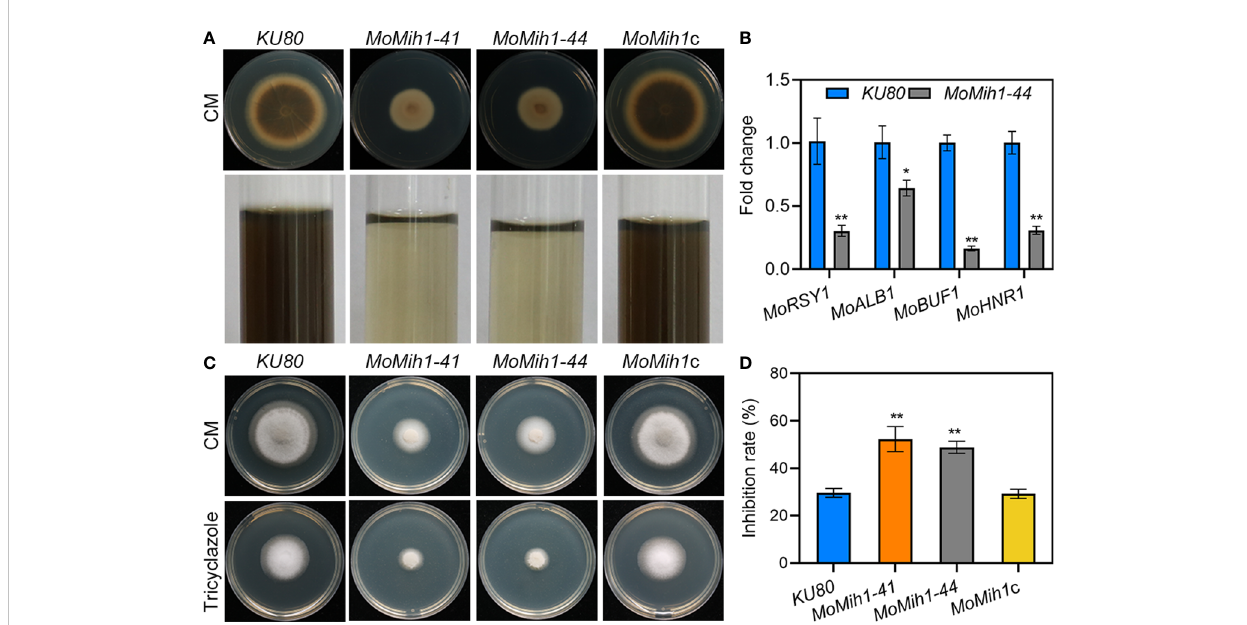
FIGURE 7 MoMih1 is required for melanin pigmentation of M. oryzae . (A) Colony pigmentation of the MoMih1 mutant. All the strains were inoculated on CM and cultured at 28°C for 5 days. Reduced melanin pigmentation was observed on both CM agar and liquid CM. (B) The transcription of melanin synthesis genes in the hypha of MoMih1 mutant. The expression levels of MoRSY1 , MoALB1 , MoBUF1 and MoHNR1 was examined by qRT-PCR, with all of them signi fi cantly decreased expression in the MoMih1 mutant. “ ** ” mean signi fi cant difference in gene expression between two strains ( p < 0.01), and error bars represent SD. (C) Sensitivity of the MoMih1 mutant to tricyclazole. The MoMih1 mutant was inoculated on CM amended with tricyclazole, cultured at 28°C for 5 days, and then fungal colony was recorded. (D) Statistical analysis of the inhibition rate under tricyclazole stress. “ ** ” stands for the signi fi cant difference between KU80 and MoMih1 mutants ( p < 0.01), and error bars represent